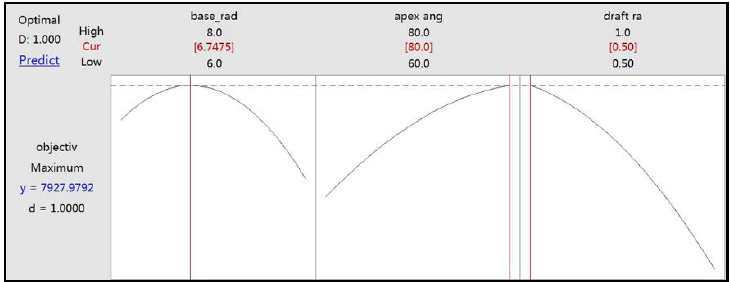
Figure 11. Calculation result of response surface method (RSM) optimizer.